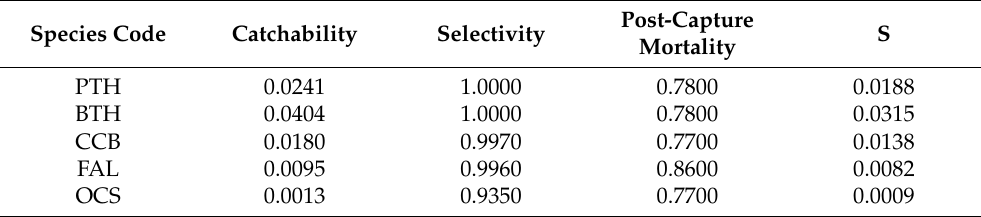
Table 4. Susceptibility parameters in the ecological risk assessment of the 20 pelagic species in the western North Pacific. The susceptibility (S) reflects the risk of fisheries development. The S is multiplied by three parameters, catchability, selectivity and post-capture